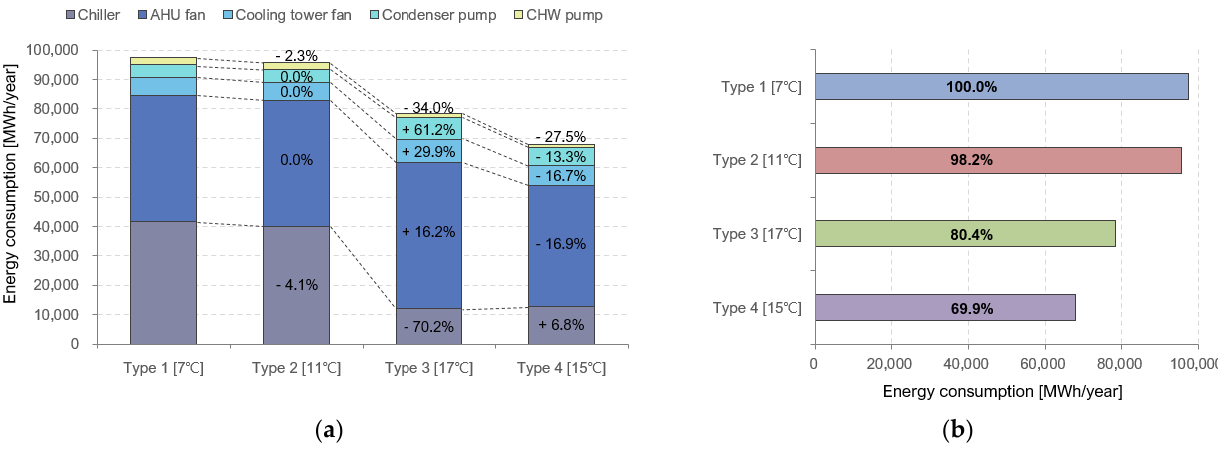
Figure 10. Total energy reduction trend for each system type compared to a conventional model. ( a ) Energy reduction rate of cooling system equipment by type, ( b ) total energy consumption by type.